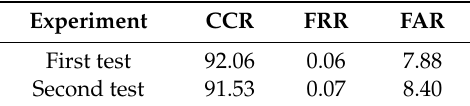
Table 5. Correct Classification Rate, False Rejected Rate and False Accepted Rate for subgroup of six